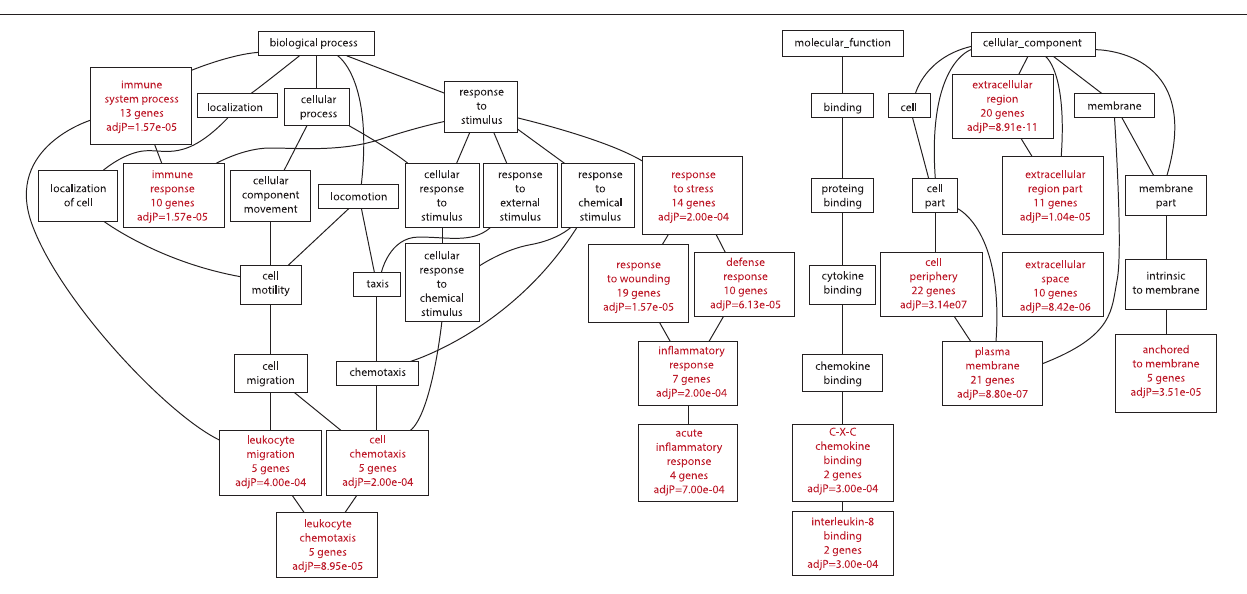
FIGURE 8 | Biological processes impacted by up-regulated genes in animals infected with strain 46 compared with animals infected with strain 46P at day 21